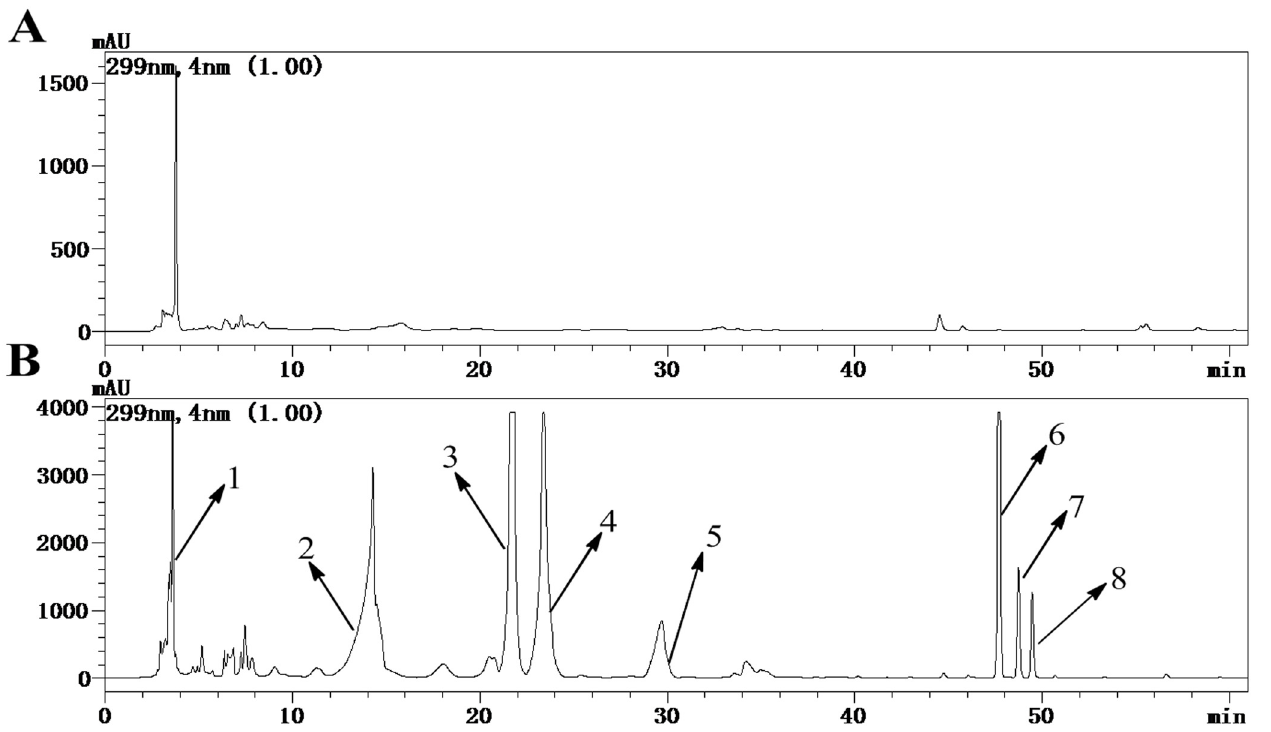
Fig 1. HPLC chromatogram of WS010117 metabolites in urine of control (A) and administrated (B) rats at 299 nm. Peak 1: 3.60 min (M1); 2: 14.15 min (M2); 3: 21.58 min (M3); 4: 23.25 min (M4); 5: 29.48 min (M5); 6: 47.68 min (M6); 7: 48.73 min (M7); 8: 49.44 min (M8).